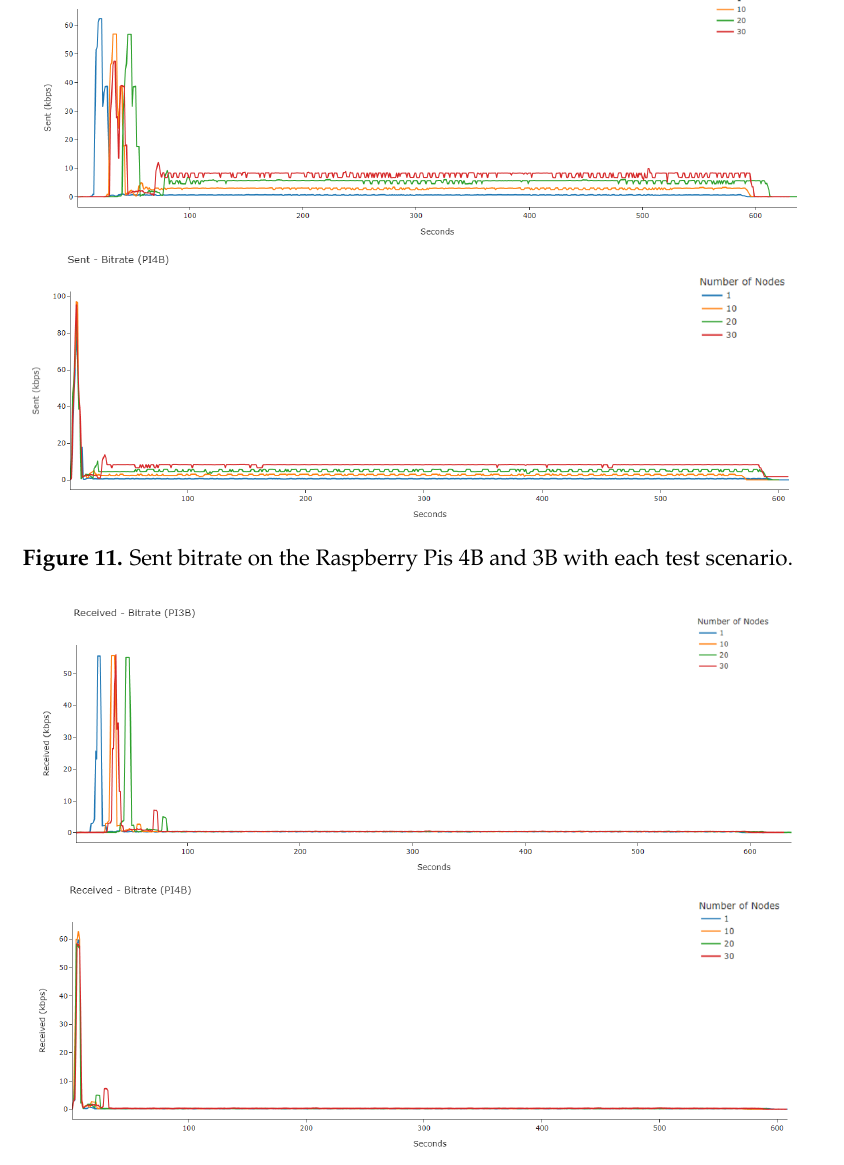
Figure 12. Received bitrate on the Raspberry Pis 4B and 3B with each test